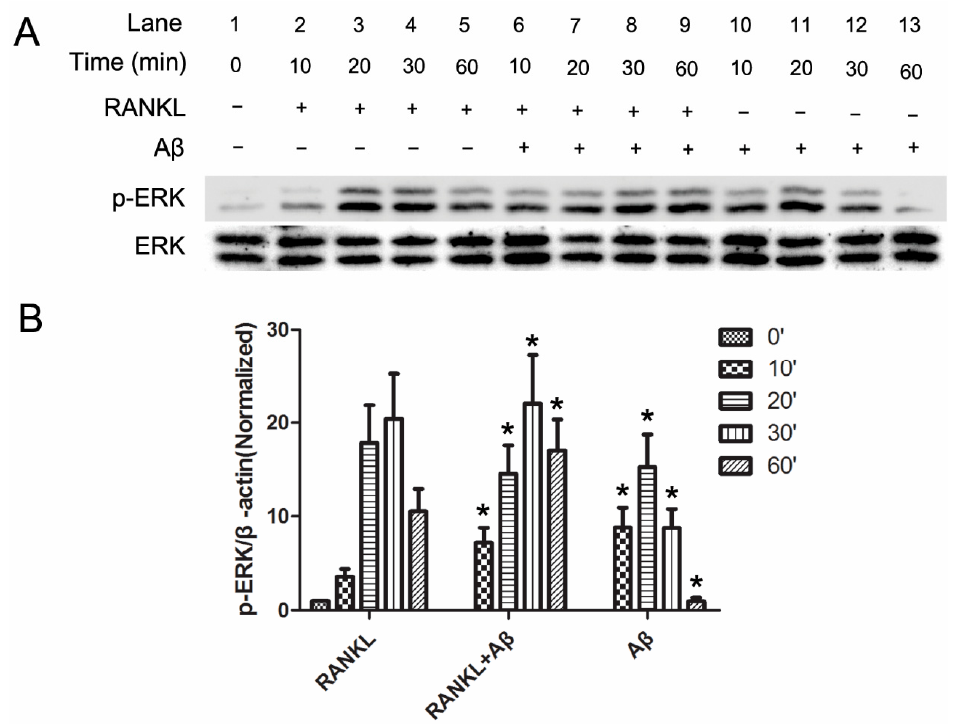
Figure 3. A β 42 induces the phosphorylation of ERK. ( A ) BMM cells were starved in serum free media for 4 h and incubated with or without A β 42 (5 µ M) in the last hour, followed by treatment with RANKL (50 ng/mL) for the indicated time points. Cell lysates were subjected to immunoblotting and activation of signaling molecules were evaluated using phosphorylated antibody against ERK; ( B ) Average ratio of p-ERK relative to β -actin. Western blot signal intensities were qualified by Image J. p-ERK/ β -actin ratios were normalized to 0 min, results are presented as mean ± SD. ′ in B stands for minute. * p < 0.05 vs. control group with RANKL treatment alone at the corresponding time point.